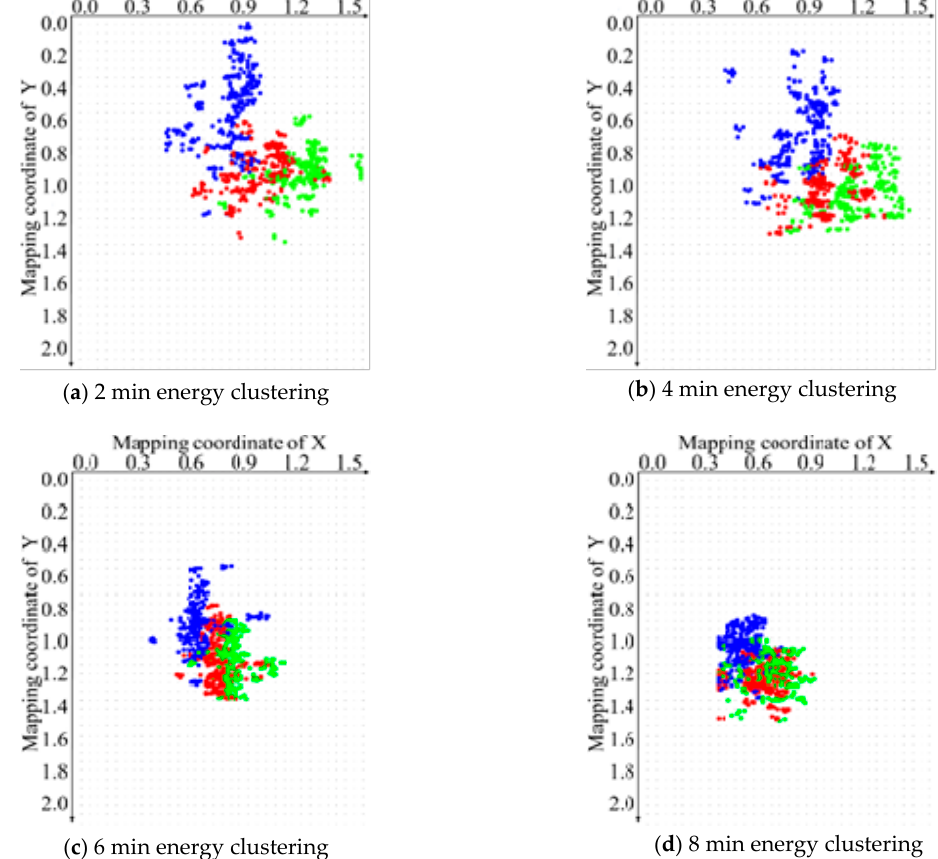
Table 1. Statistical data of tea image energy clustering training at di ff erent fixation